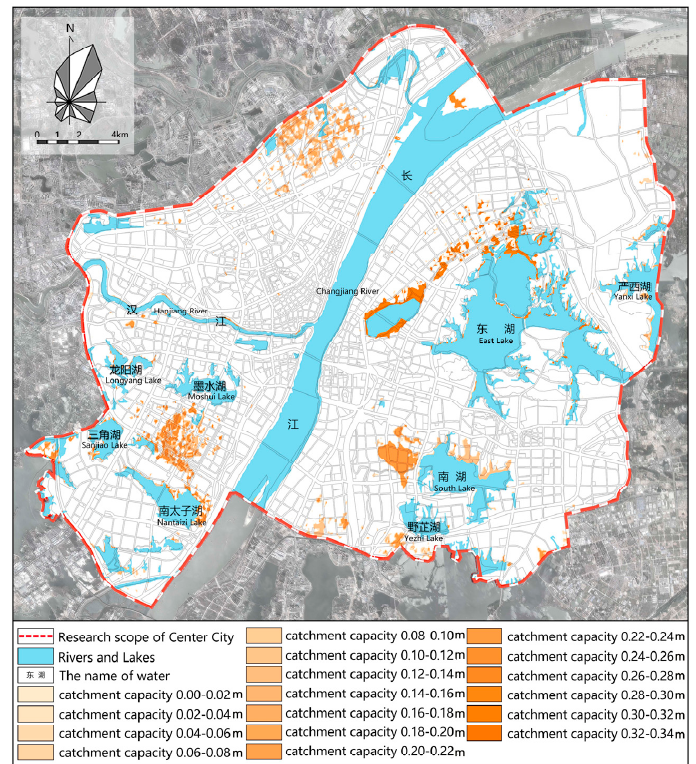
Figure 9. Simulated catchment capacity of the flood-submerged areas.